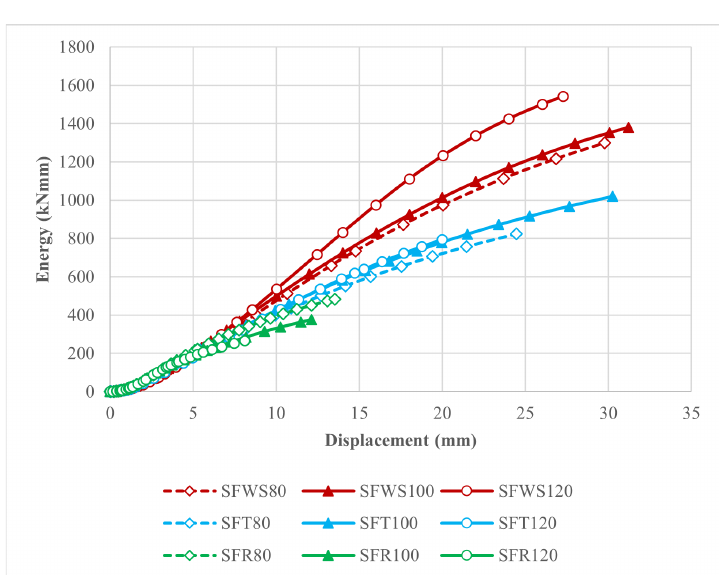
Figure 3. Energy absorption